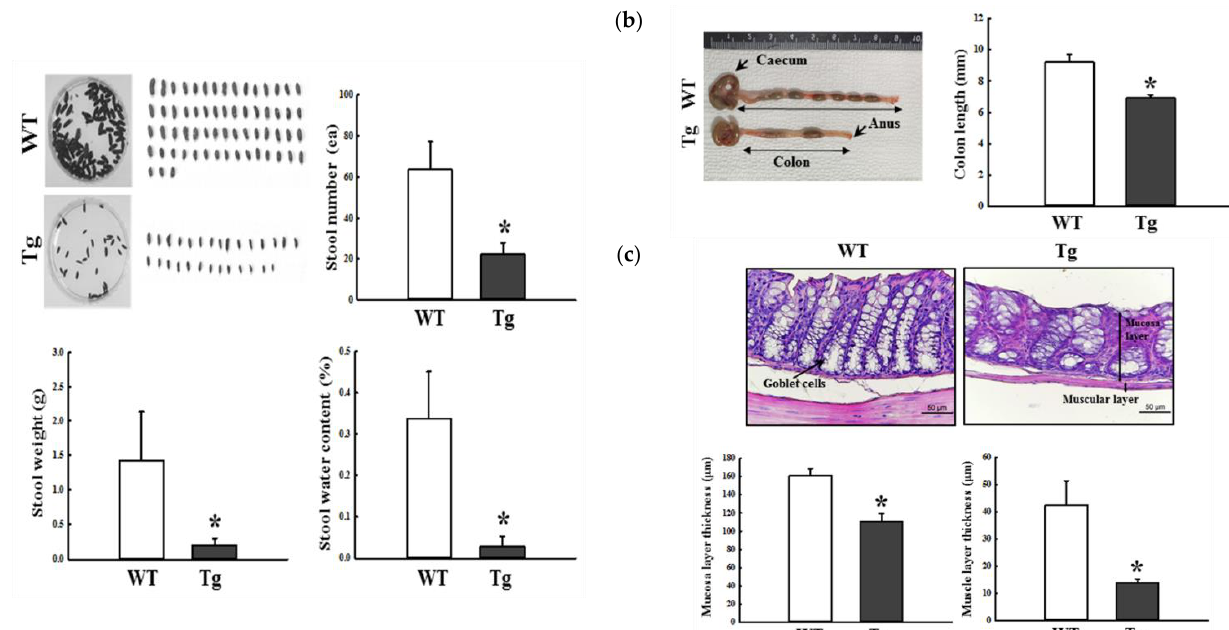
Figure 1. Stool parameters, colon length, and histopathological structures of the mid colon in Tg2576 mice. ( a ) Stool parameters. After collecting and taking digital camera images of the stools, the changes in the number, weight, and water contents of the stools were measured, as described in Materials and Methods. Stools were collected from three to five mice per group, and each parameter was assayed in duplicate. ( b ) Colon length. After collecting the colon, the total length was measured from the caecum to the anus. Five to six mice per group were used to prepare the colon, and the colon length was measured in duplicate. ( c ) Histological analysis. After staining with H&E solution, histological features were observed at 400× magnification using an optical microscope. Alteration of their parameters was determined using the Leica Application Suite. H&E-stained slides were prepared from three to five mice per group, and the histopathological parameters were measured in duplicate in each tissue section. The data are reported as the mean ± SD values. *, p < 0.05 compared to the WT group. Abbreviations: WT, wild-type; Tg, Tg2576 mice; H&E, hematoxylin and eosin.